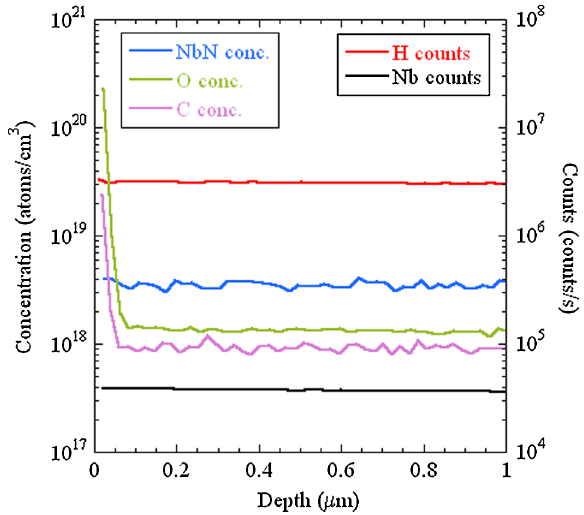
FIG. 20. (Color) SIMS reduced data depth profile for control sample L14.